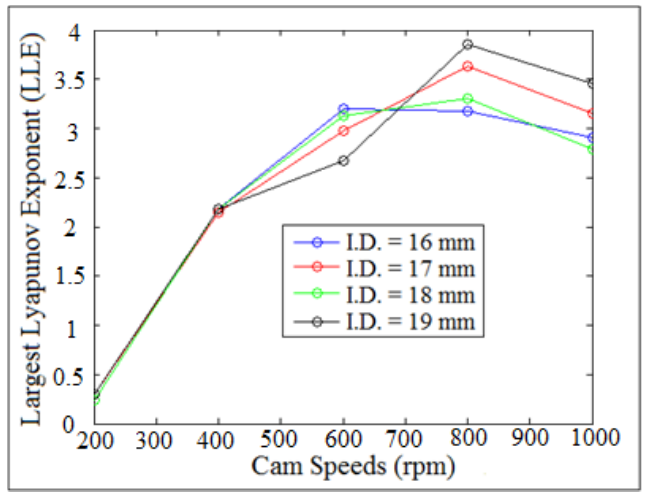
Figure 36. Largest Lyapunov exponent against cam speeds.